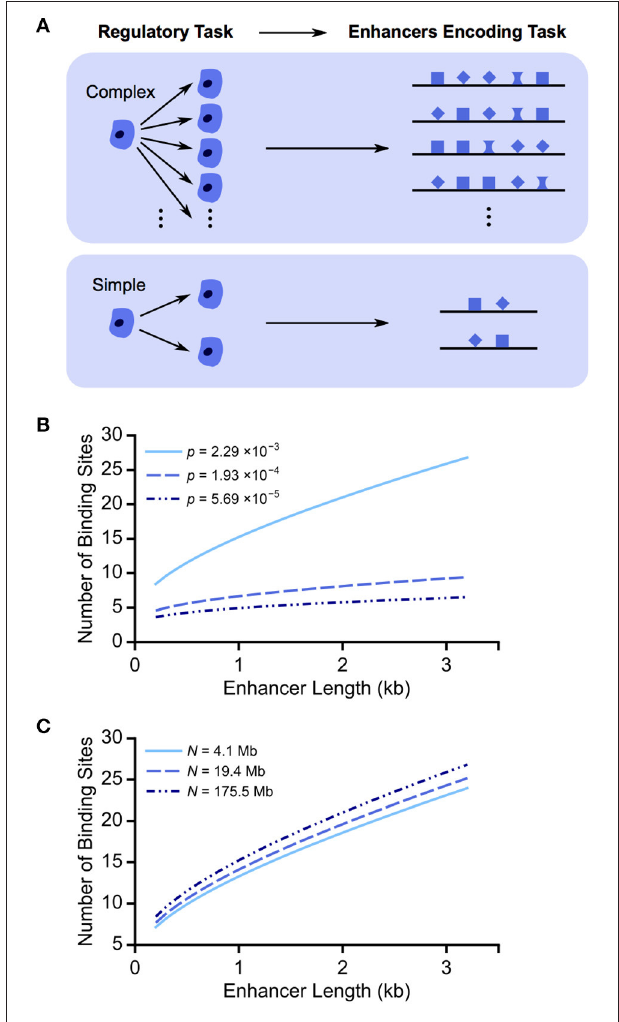
FIGURE 1 | Regulatory task complexity can shape enhancer length and binding site composition. (A) We propose that more complex regulatory tasks, e.g., cell patterning decisions, are associated with longer enhancers with more binding sites. More binding sites can be arranged within an enhancer in more ways, allowing for the specification of a wider variety of expression patterns and, therefore, more complex tasks. (B) We plot the minimum number of TF binding sites required for enhancers of varying lengths to achieve distinguishability from the genomic background. We show the results for three motif hit probabilities, corresponding to the median, first and third quartiles of Drosophila TF binding specificities. As motif hit probability p decreases from ∼ 2 in 1kb (2 × 10 − 3 ) to ∼ 6 in 100 kb (6 × 10 − 5 ), an enhancer of the same length requires fewer binding sites to be distinguishable from the background. (C) To test the effect of genome accessibility, we plot the minimum number of TF binding sites required for enhancers of varying length in the context of different accessible genome sizes ( N ). Varying the accessible regions of the genome has a minor impact on the trend of numbers of TF binding sites increasing with enhancer